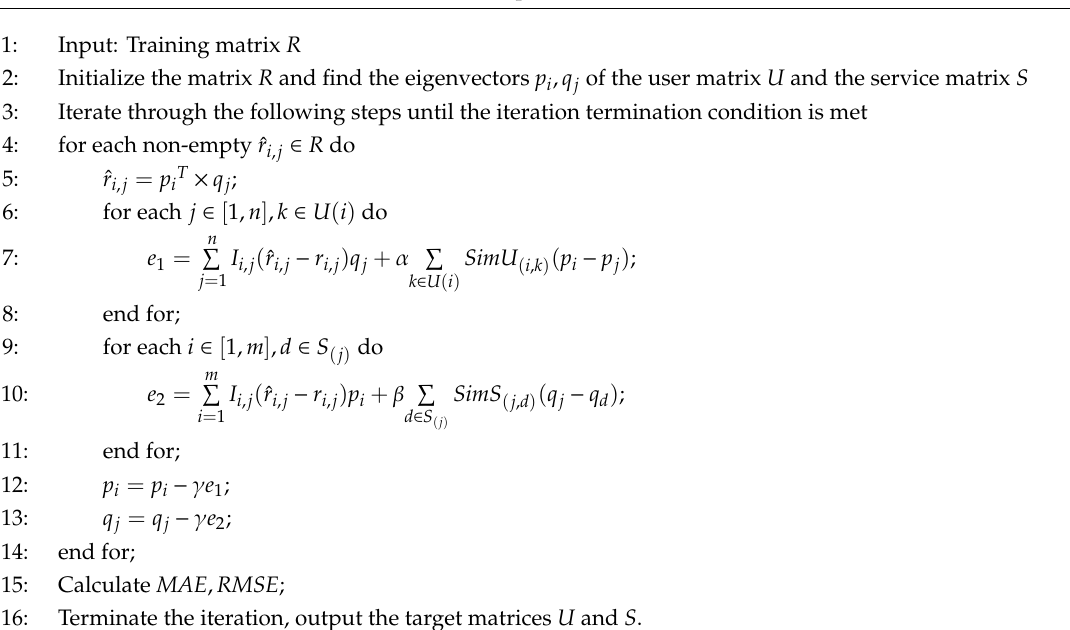
Algorithm 3 Gradient descent iteration to find the optimal